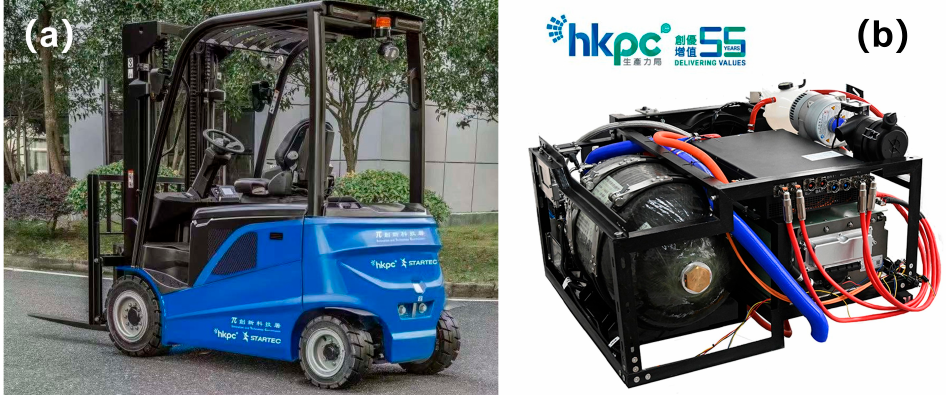
Figure 1. ( a ) Hong Kong’s first hydrogen-powered forklift launched by HKPC. ( b ) The fuel cell hybrid system inside.